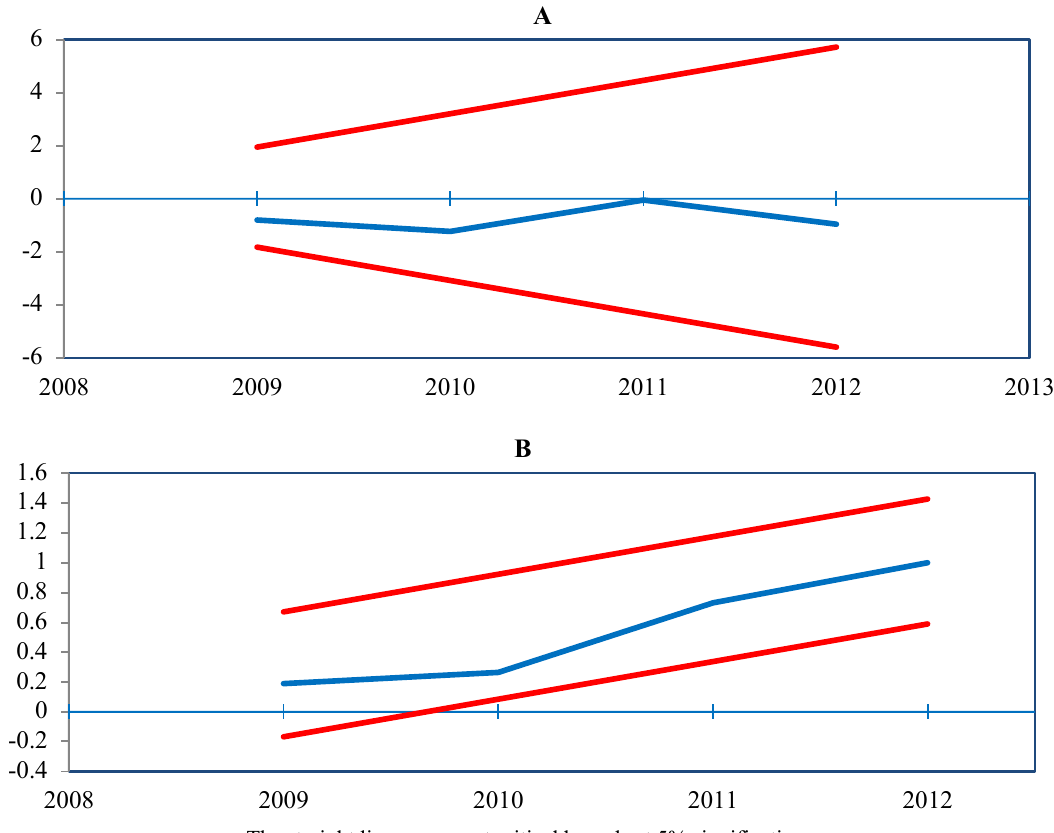
Figure 2. A: Plot of the cumulative sum of recursive residuals B: Plot of the cumulative sum of squares of recursive